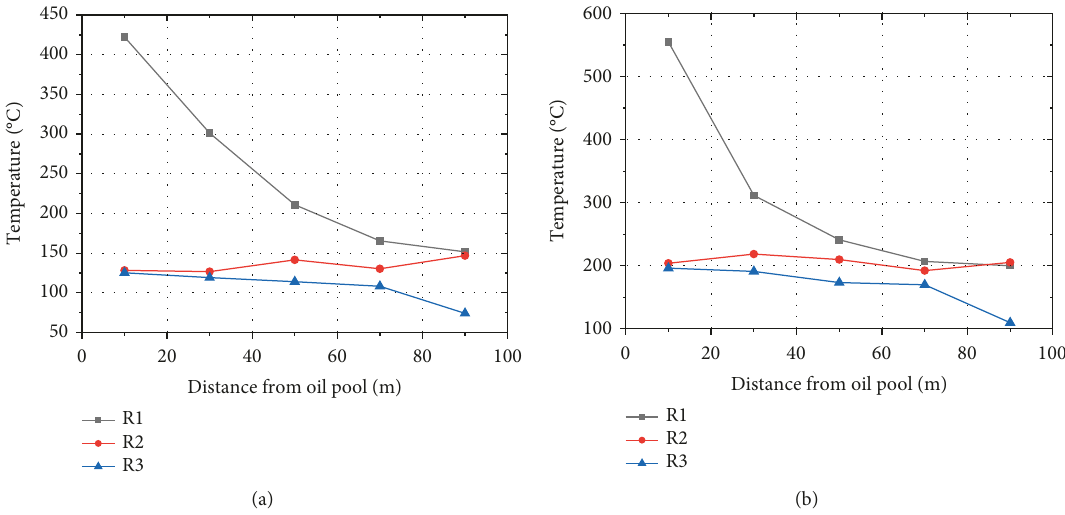
Figure 12: Average temperatures in different diameters vary with distance. (a) D � 15cm. (b) D � 20